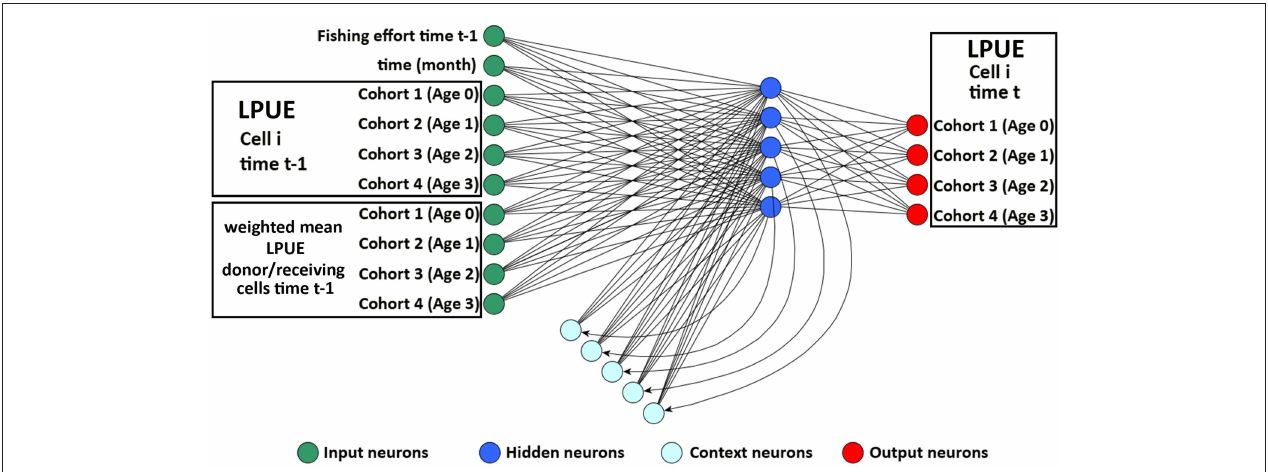
FIGURE 3 | Representation of the Elman network devised to process temporal time series of LPUE for each species in the model. The input layer comprises three blocks of neurons: one for fishing effort and time, one for the temporal series of LPUE, by age, in cell I, and one for the temporal series, by age, of mean LPUE in the donor/receiving cells. The input neurons directly propagate the information to the basic hidden neurons. At each step of the training procedure, the updated pattern of the basic hidden neurons is memorized by the context neurons and, at the successive step, propagated to the basic hidden neurons together with the new information in the input neurons. The output layer contains as many neurons as the number of age classes of the species considered. Modified from Russo et al.